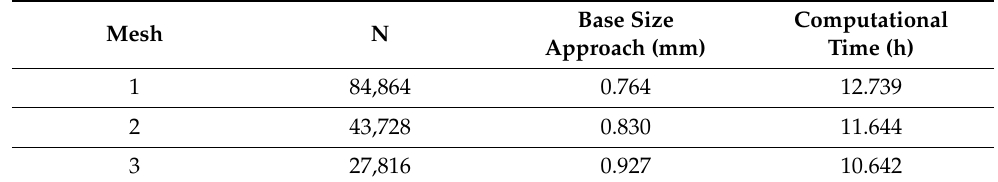
Table 5. The computational time for the unsteady-state simulation with DFBI running for 0.11 s of physical time. Mesh N